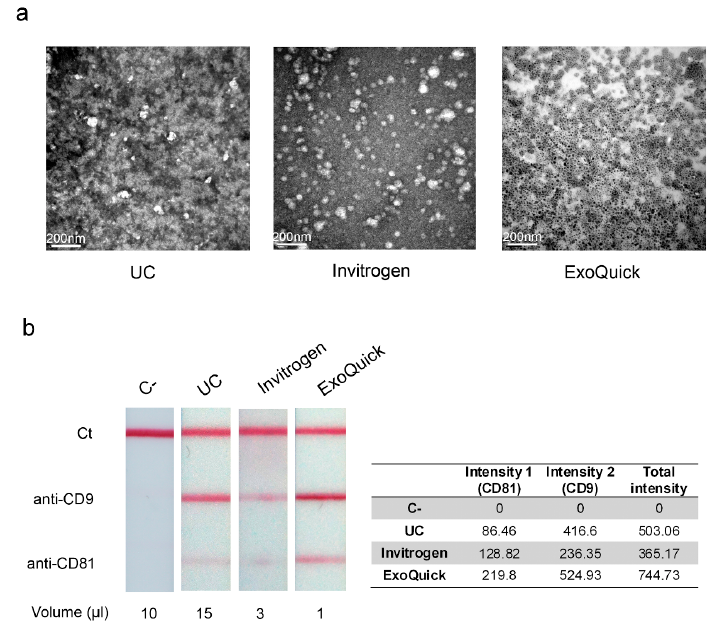
Figure 4. Observation and detection of isolated EV. ( a ) Transmission electron microscopy images representative of plasma-derived EV by ultracentrifugation or using commercial precipitation reagents (Invitrogen or ExoQuick). ( b ) Detection of the EV isolated by lateral flow immunoassay (LFIA), using anti-CD9 and anti-CD81 as capture antibodies, and reflectance measurements of AuNPs on each test line (estimated as the peak area of the signal in mV × mm). EV-depleted plasma was used as a negative control (C − ). Unbound antiCD63-AuNP captured with anti-IgG were used as system functional verification